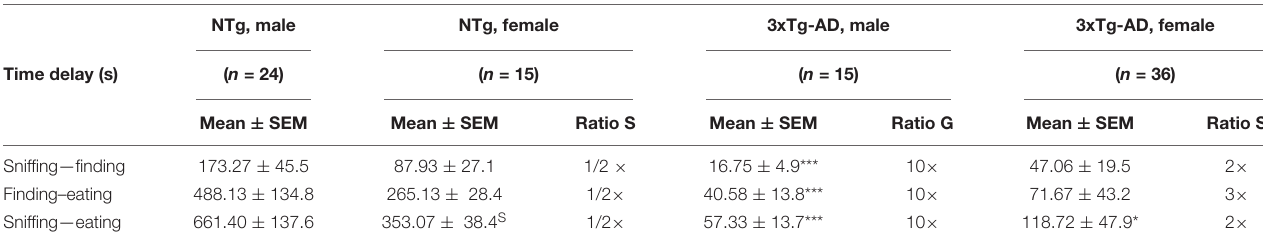
TABLE 1 | AD-genotype and sex effects in the time delay between